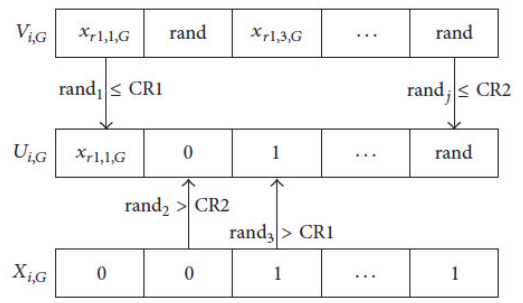
Figure 2. Dichotomous crossover example.